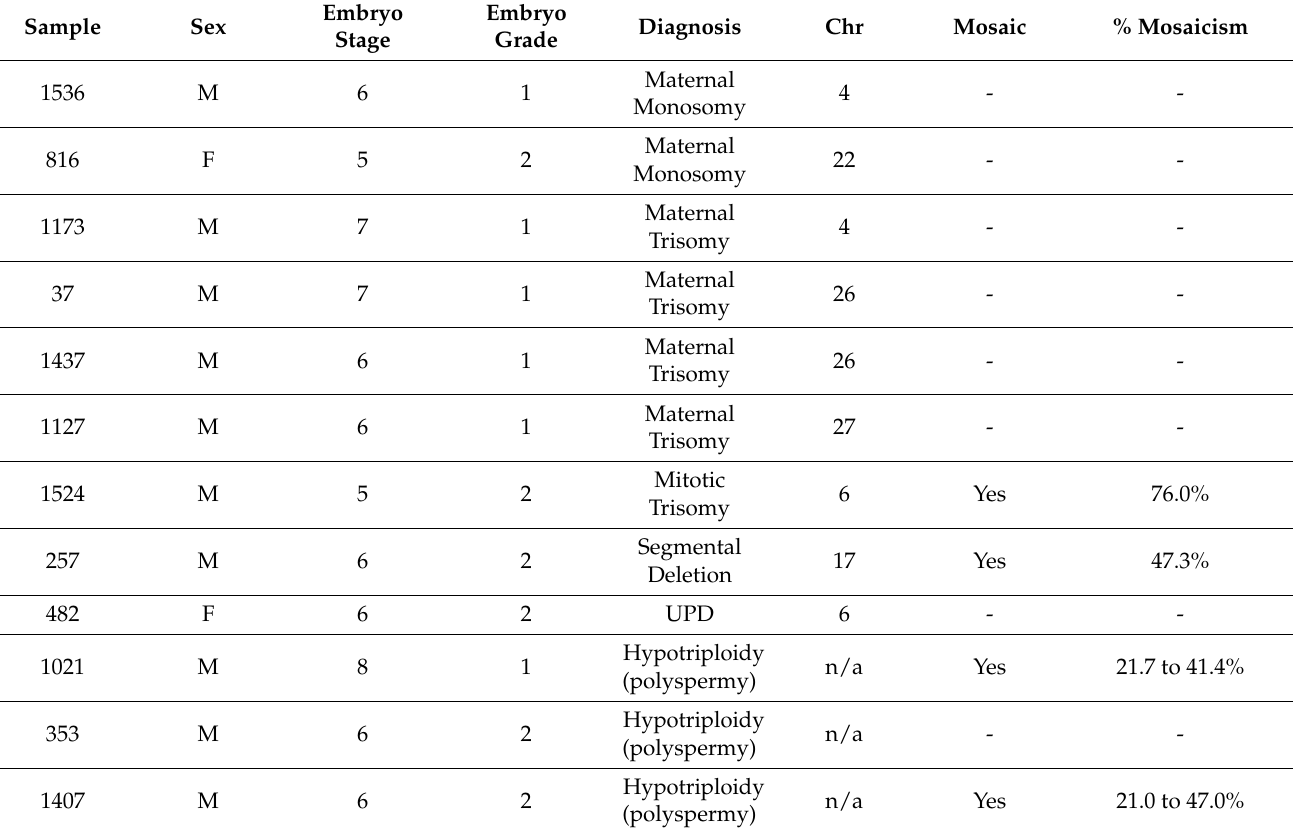
Table 3. Live birth cases from aneuploid embryos. Chr = chromosome; UPD = uniparental